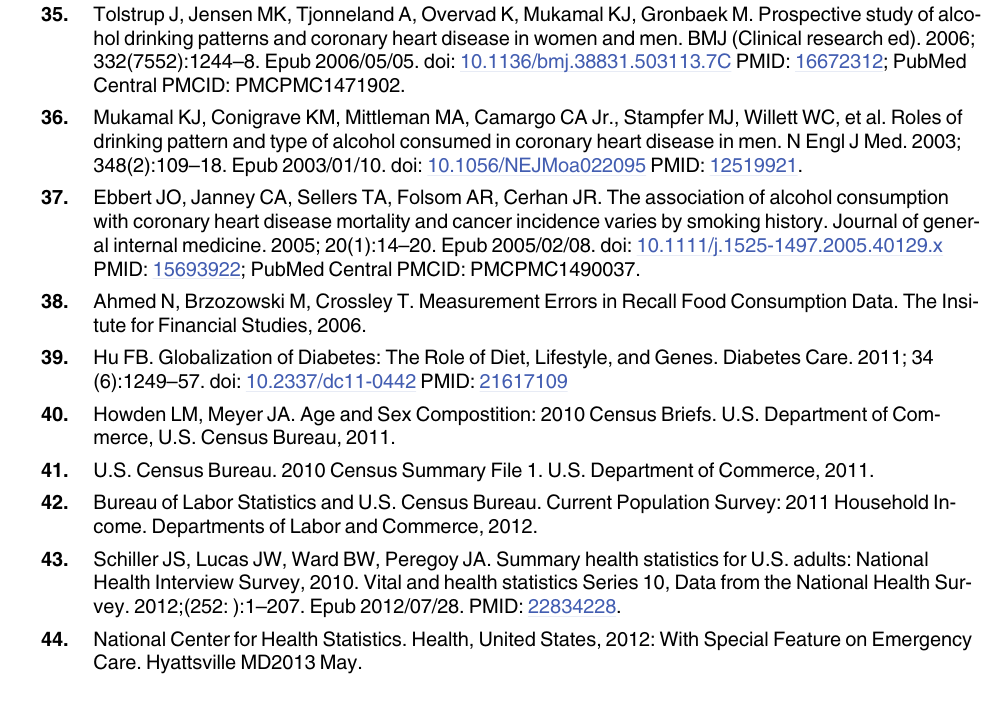
PLOS ONE | DOI:10.1371/journal.pone.0124351 May 11, 2015 12 /